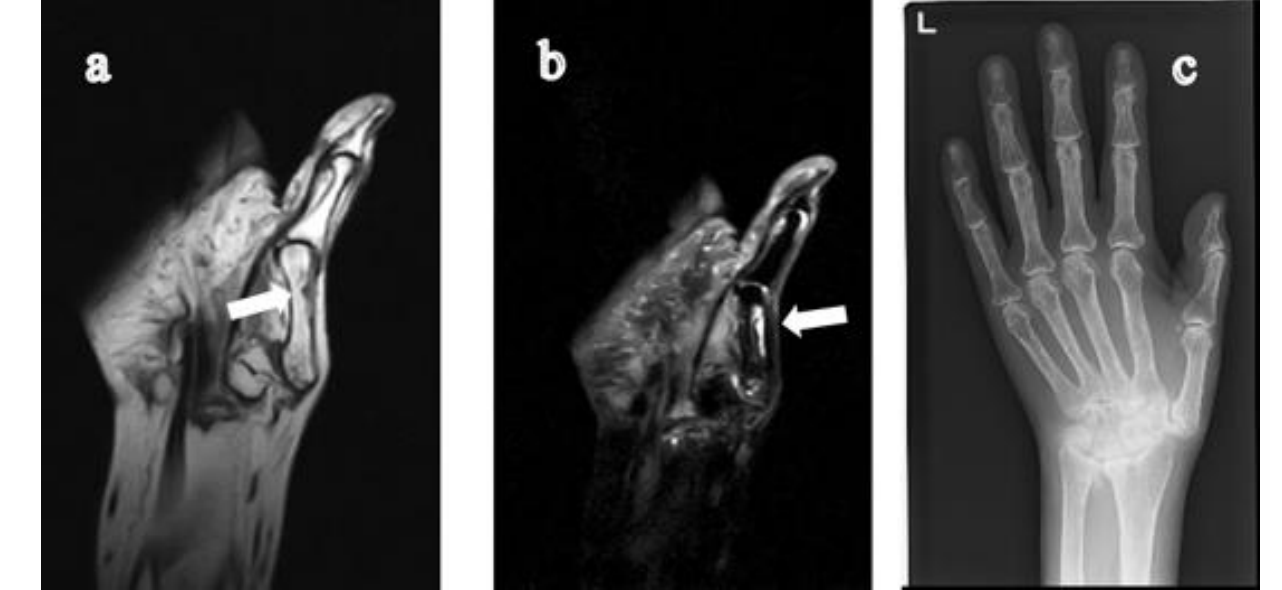
Figure 1. 60-year-old woman with rheumatoid arthritis for 28 years. There is a cystic lesion in the 1st metacarpal bone of the left hand, which originates from the head of the 1st metacarpal bone extending to the central diaphysis. The lesion appears as a low signal intensity on the T1-weighted coronal image ( a ) and high signal intensity on the STIR coronal image ( b ). On CR ( c ), collapse of the carpal bone due to long-standing RA is observed; however, the lesion is not visible. RA, rheumatoid arthritis; STIR, short tau inversion recovery; CR, computed radiography.